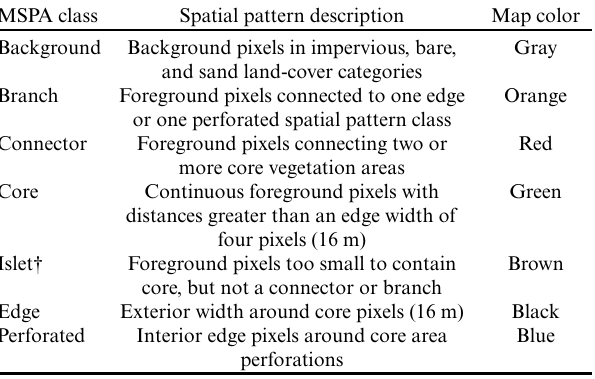
Table 1. Definition of the spatial patterns of green areas as defined by morphological spatial pattern analysis (MSPA) for this study, including the modifications of Riitters (2011).